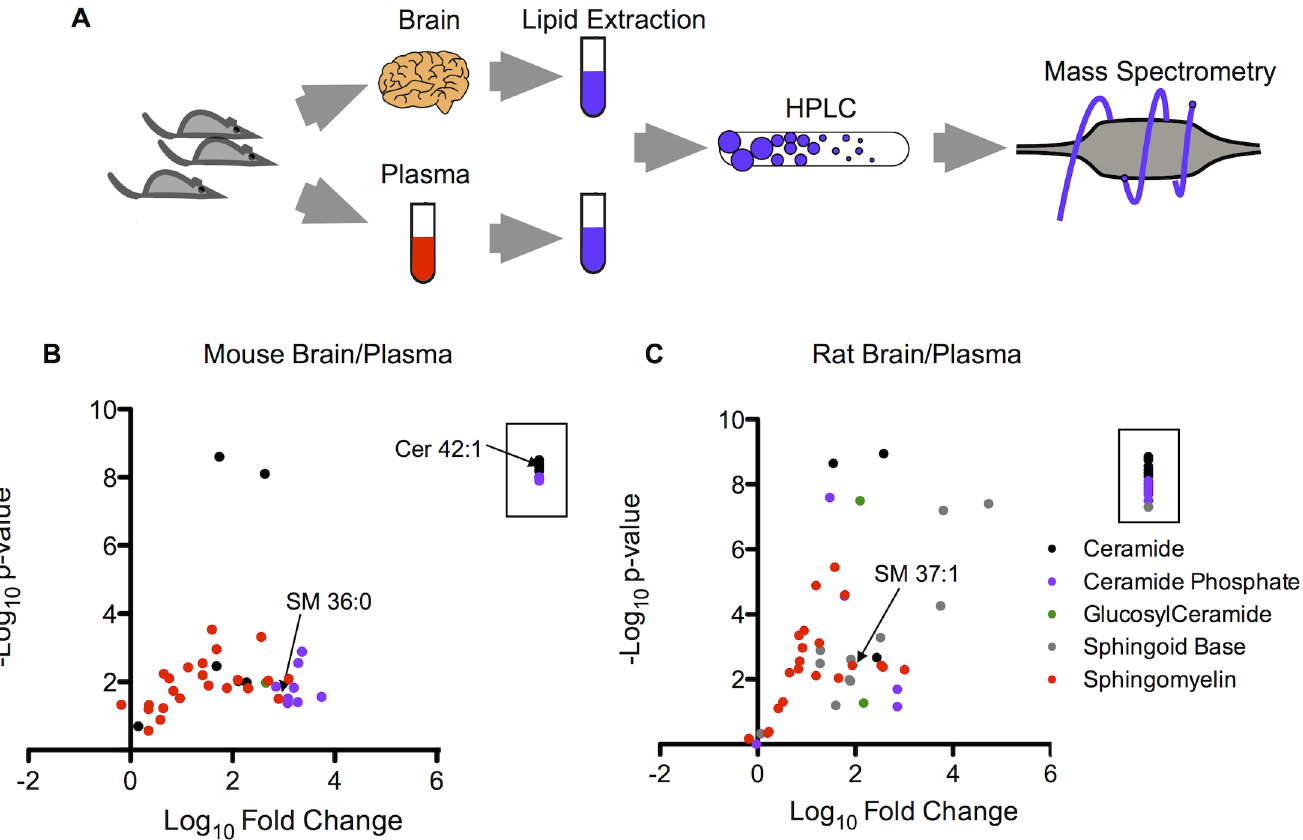
Fig 1. Targeted sphingolipid profiling in mouse and rat brain and plasma. (a) Schematic of the workflow for the isolation of rodent brain and plasma, lipid extraction, and HPLC MS/MS. (b) Volcano plot of the negative log 10 of the p-value (Student ’ s t-test, two-tailed) versus the log 10 of the normalized (to protein content) fold difference in concentration in brain over plasma for the 45 sphingolipids identified in mouse brain and plasma. Species within the box (8 total) were found in the brain but not identified in the plasma. n = 3 per sample. (c) Volcano plot of the negative log 10 of the p-value (Student ’ s t-test, two-tailed) versus the log 10 of the normalized fold difference in concentration in brain over plasma for the 56 sphingolipids identified in rat brain and plasma. Species within the box (13 total) were found in the brain but not identified in the plasma. n = 3 per